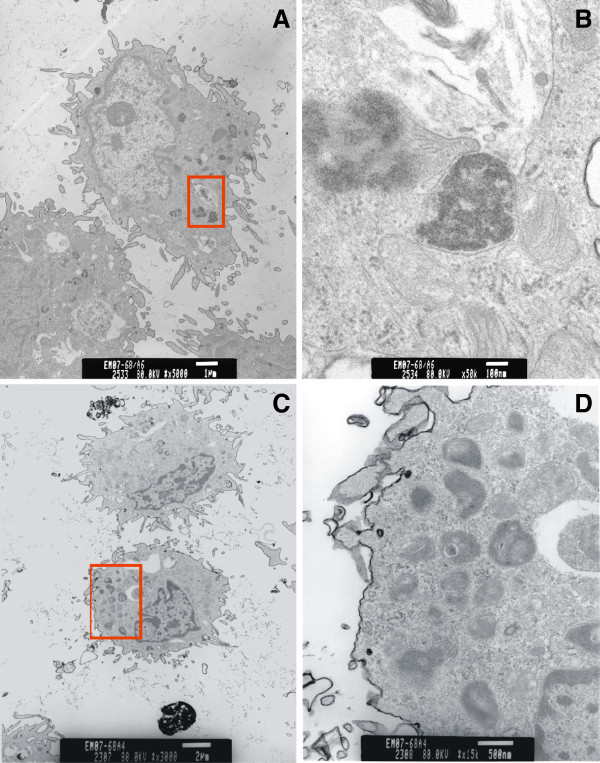
AM uptake of QD visualized by transmission electron microscopy. TEM micrographs of AM recovered by BAL at 1 day after intratracheal instillation with QD-COOH (A &B) or QD-NH2 (C &D) (12.5 μg/rat). High magnification TEMs of the area in the red box illustrate AM vacuoles containing QD-COOH (B) and QD-NH2 (D).